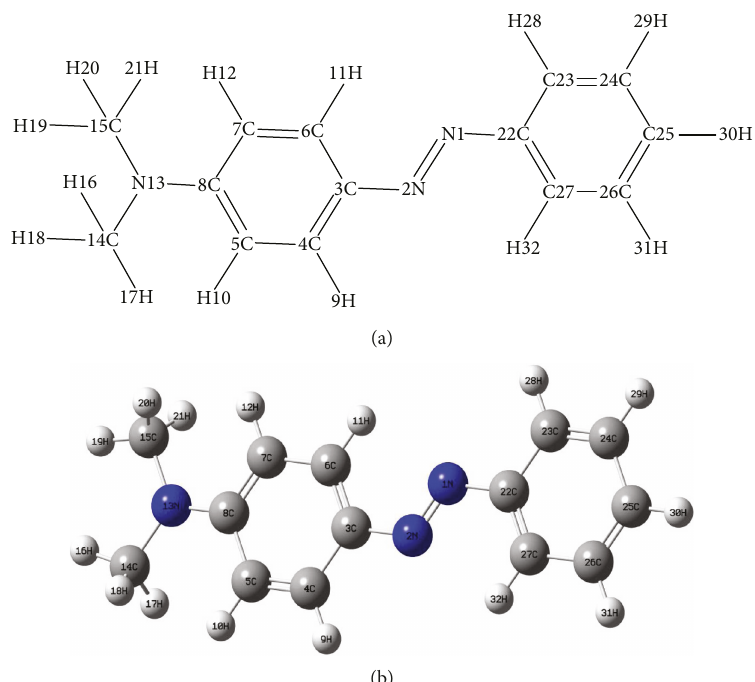
Figure 1: (a). The normal structure of DMAB with atomic numbering. (b) The optimized structure of DMAB at DFT/B3LYP/6-311G++ in the gas